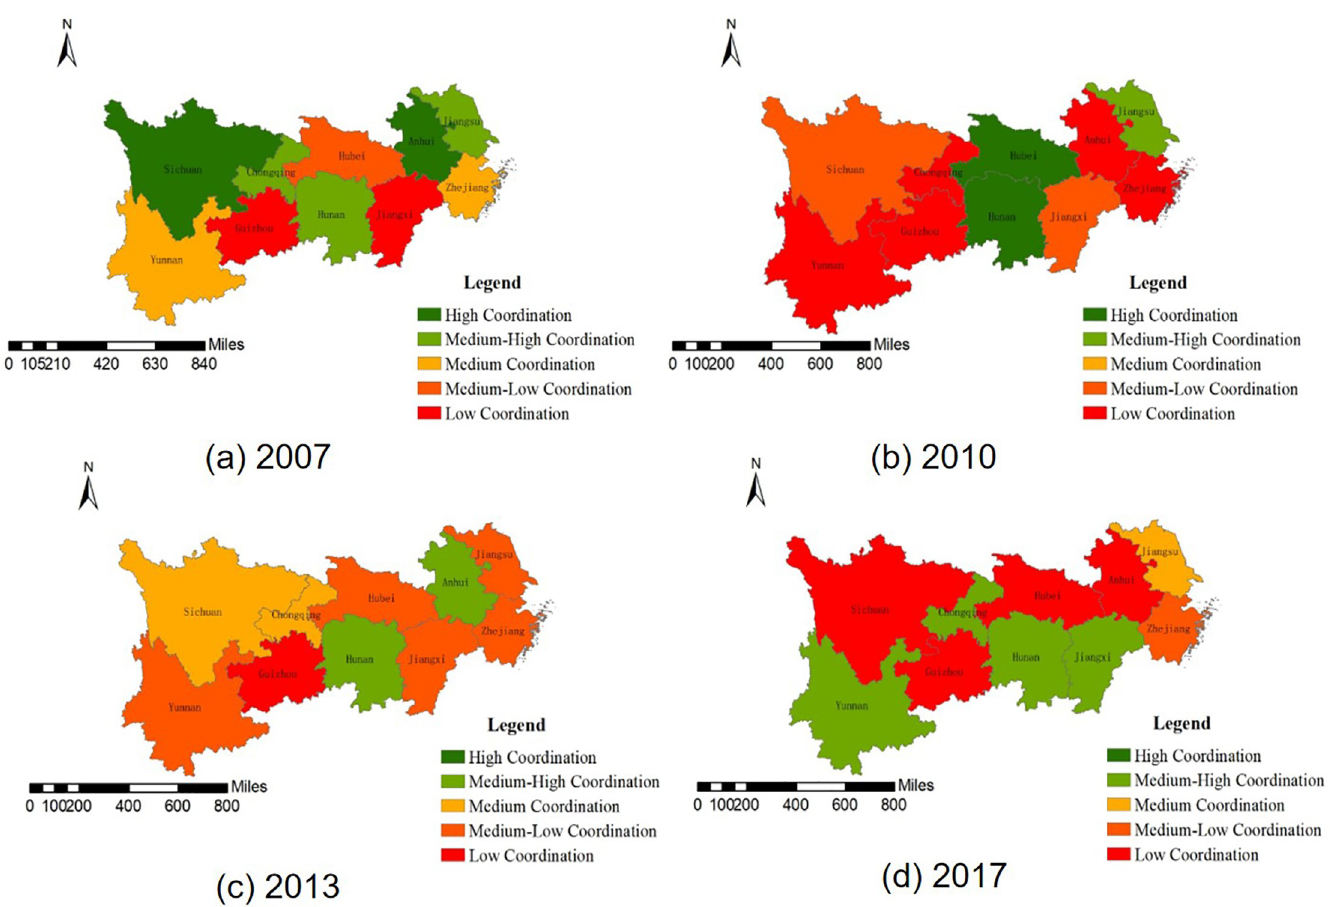
Fig 3. Speed coordination evaluation of the population-land urbanization in the YEB in 2007, 2010, 2013, 2017. a. 2007. b.2010. c.2013. d.2017. (Quoted from the Tianditu map. Source of base map: the open source map data service provided by the National Platform for Common GeoSpatial Information Services (https://www.